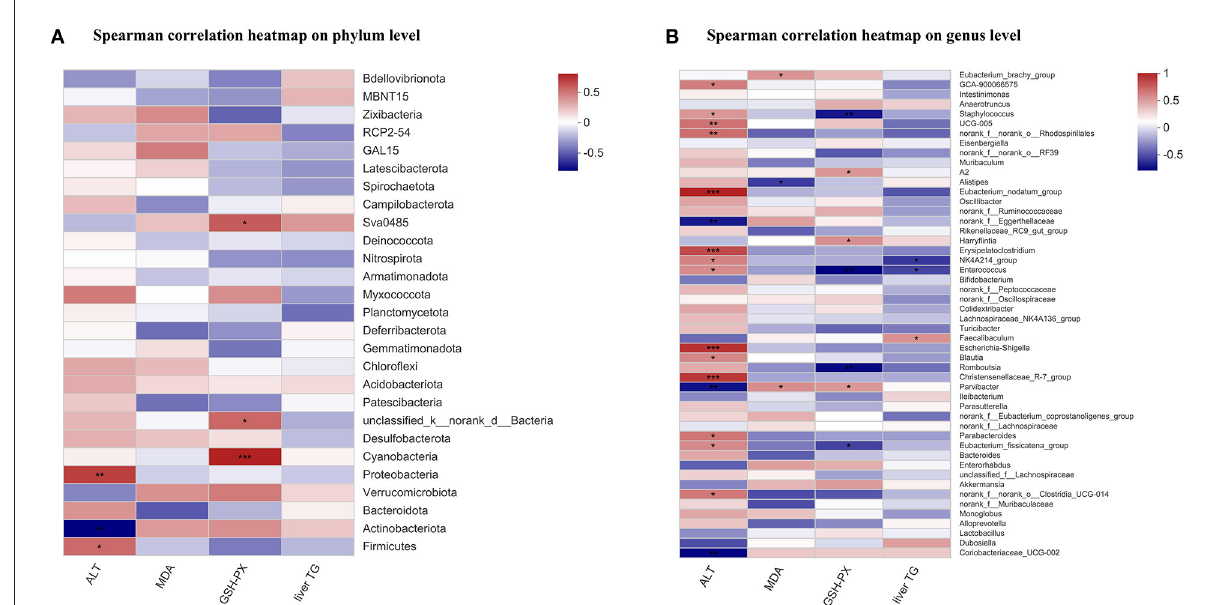
FIGURE6 Correlation analysis between liver biochemical parameters and the fecal microbiome. The Spearman’s correlation analysis linking the abundance of specific phyla (A) , or genera (B) with liver biochemical parameters. The Spearman correlation coefficient value was shown in different colors. * P < 0.05, ** P < 0.01, and *** P < 0.001 indicate statistically